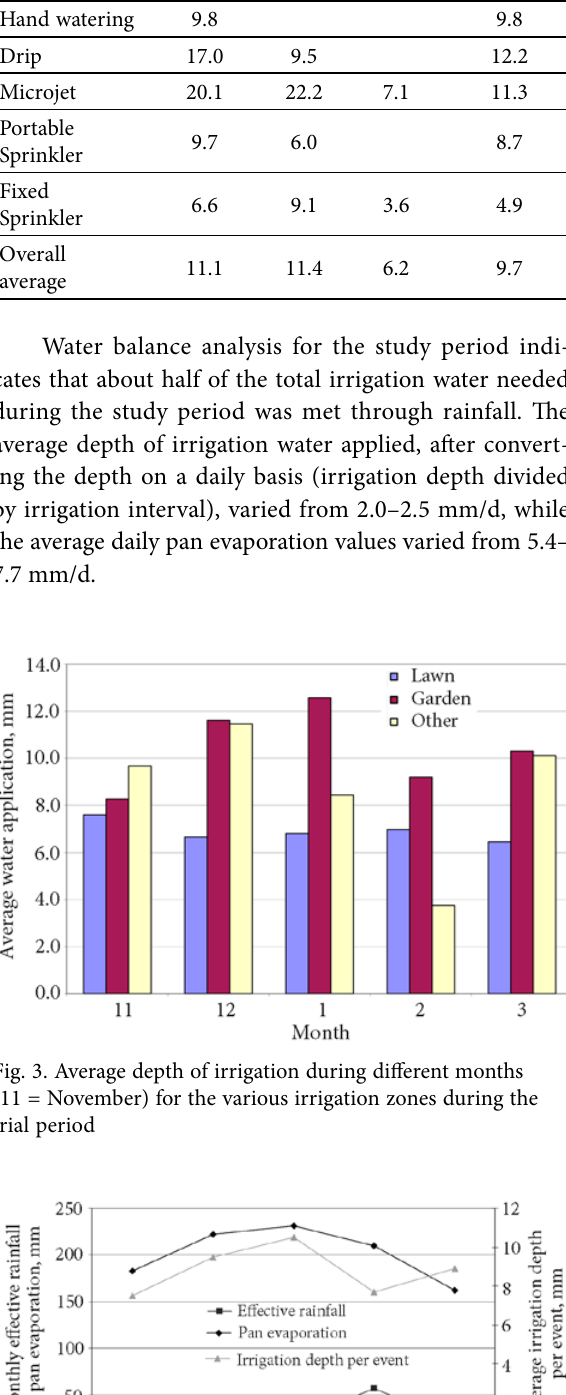
Table 4. Variation of average depth of water application per irrigation with irrigation systems and system controls Irrigation